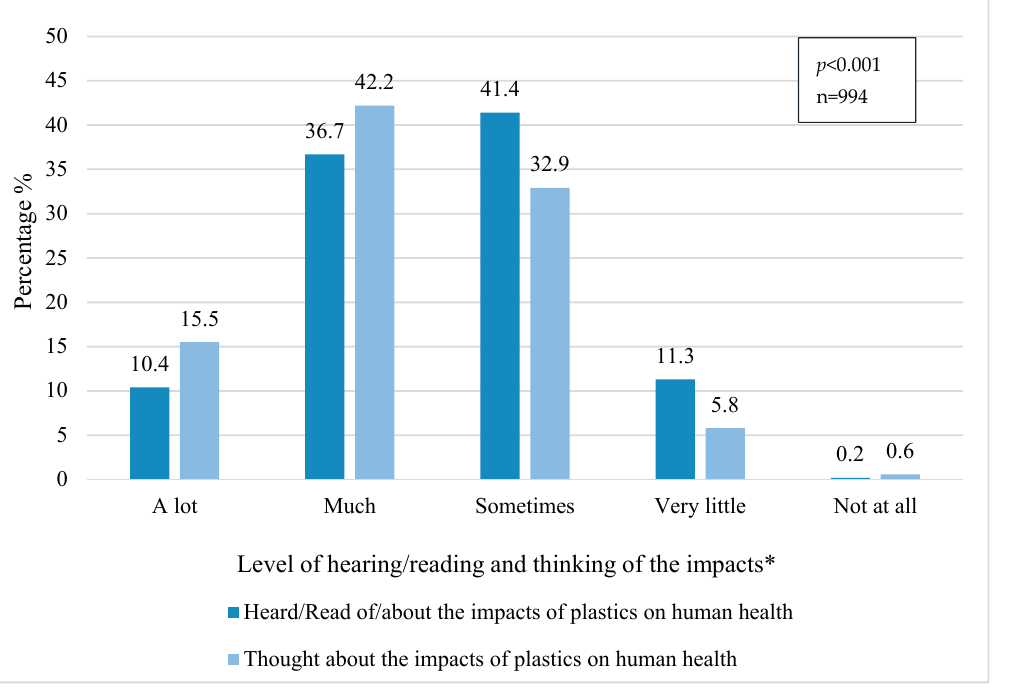
Figure 6. Receiving information and thinking about the impact of plastics on health. * Significant relation (chi2, p < 0.001) between receiving information and thinking about the impact of plastics on health.